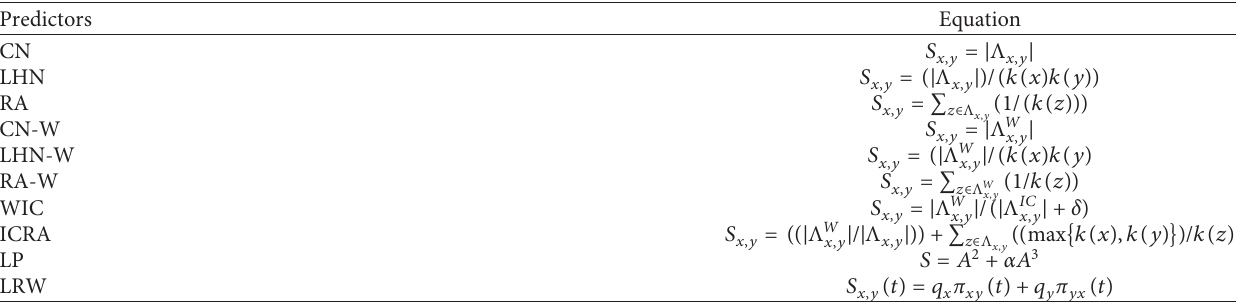
Table 1: Similarity-based algorithm.